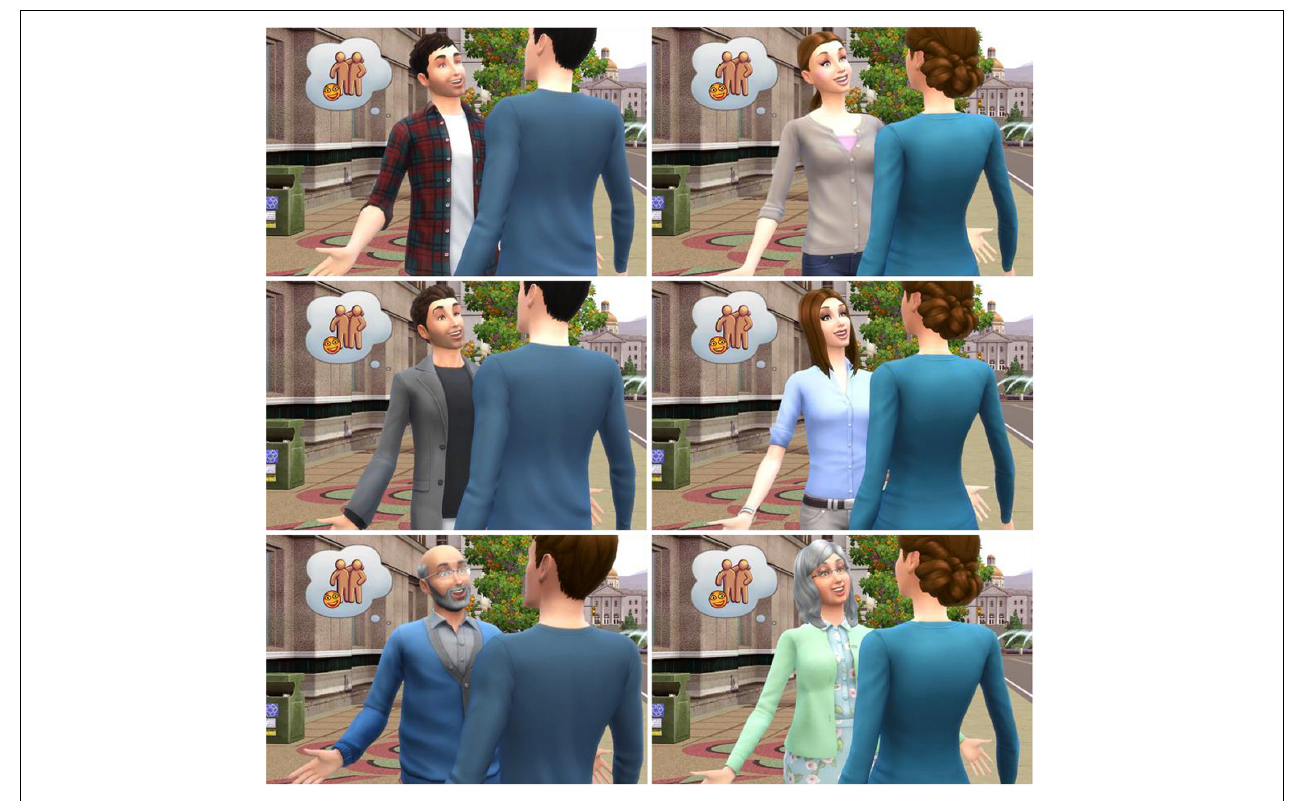
FIGURE 1 | Social targets included in the current study. From top to bottom: non-cocaine user, cocaine user, elderly person. Left, male; right,